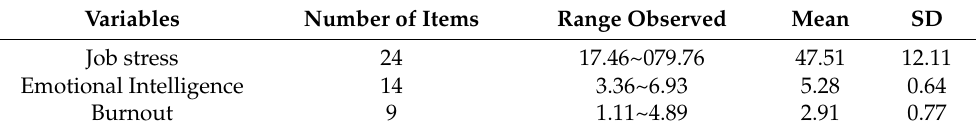
Table 2. Properties of job stress, emotional intelligence, and burnout questionnaires. Variables